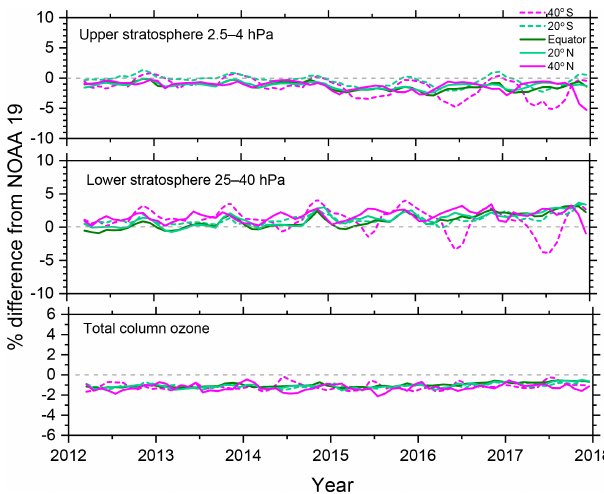
Figure 10. The time dependence of the version 2 ozone anomaly relative to NOAA 19 shown for low to midlatitudes.